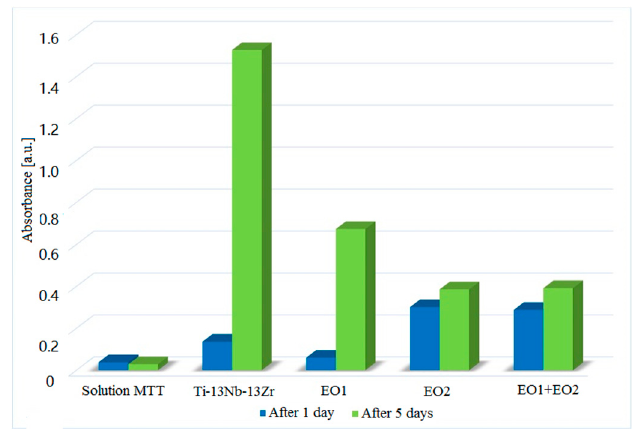
Figure 8. Growth of bacterial film of Staphylococcus aureus strain on the tested samples surfaces.